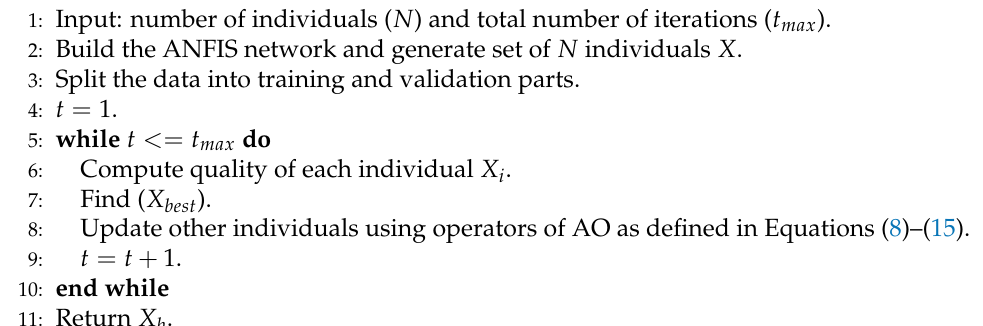
Algorithm 2 Proposed AO-ANFIS